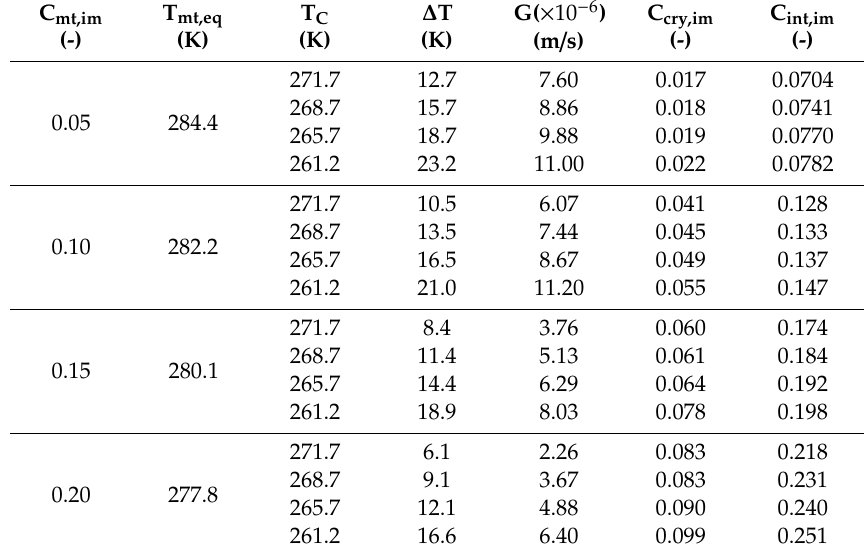
Table 1. The experimentally measured data of G and C cry,im for C mt,im = 0.05–0.20 operated at T C = 261.2–271.7 K from the binary PX / OX mixture.